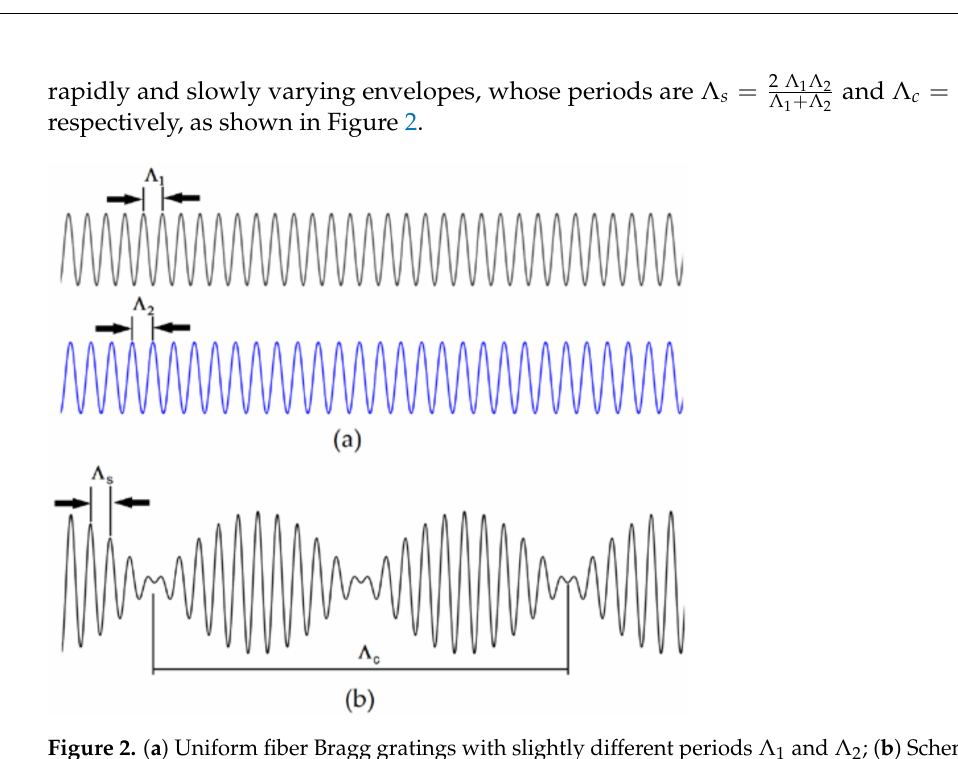
Figure 2. ( a ) Uniform fiber Bragg gratings with slightly different periods Λ 1 and Λ 2 ; ( b ) Schematic of the Moir é grating structure with rapidly varying Λ s and slowly varying Λ c envelopes.